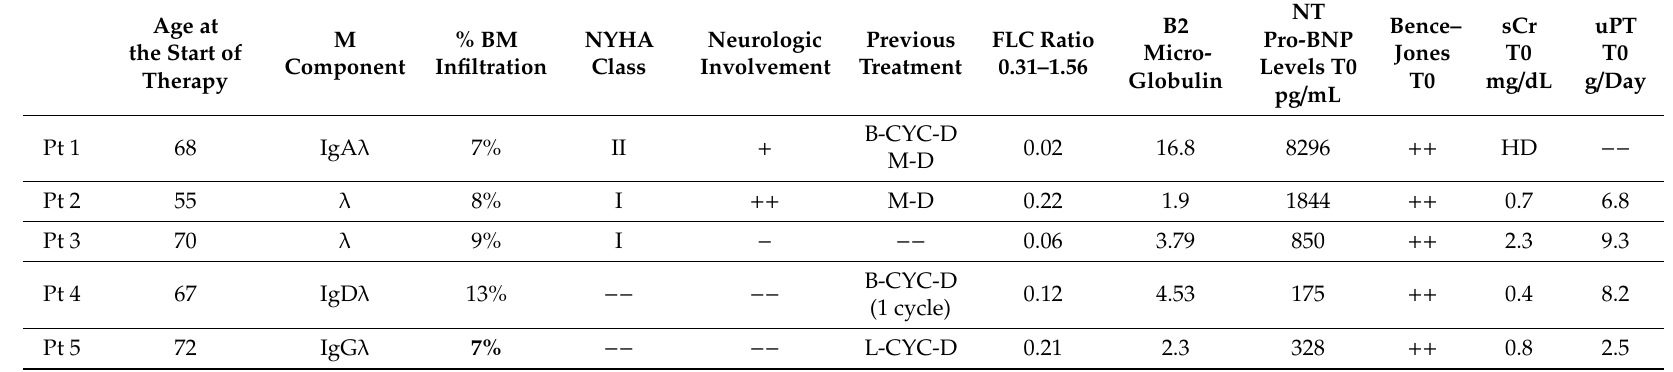
Table 1. Baseline clinical laboratory